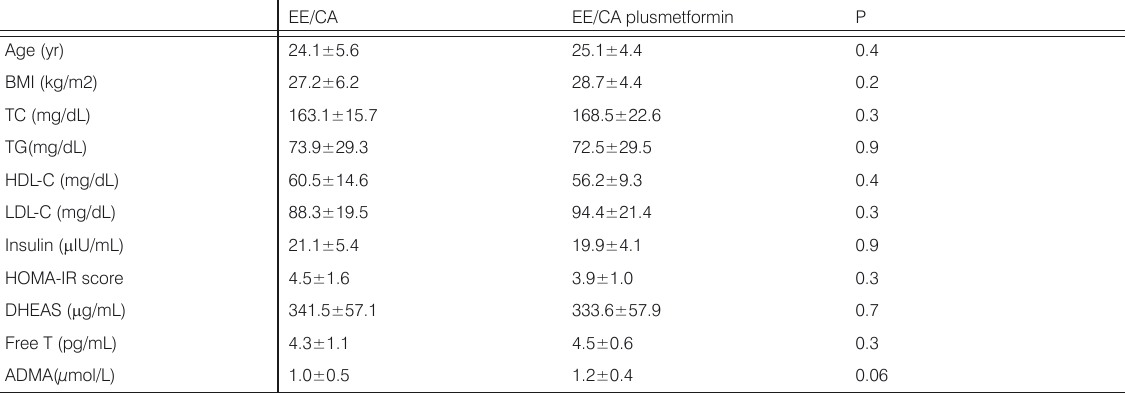
Table 1. Pre -treatment hormonal and metabolic features of the women studied (mean±SD).